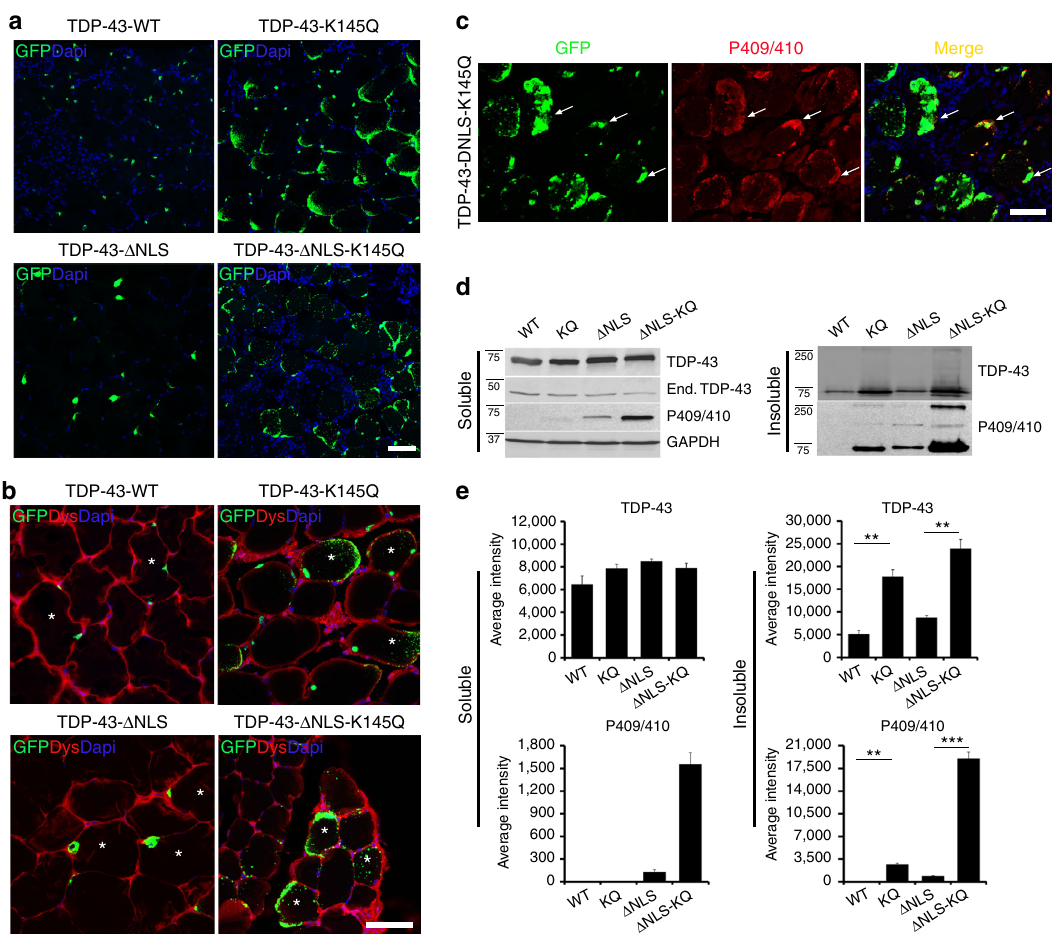
Fig. 2 TDP-43 acetylation-mimics generate hallmark disease pathology in vivo in mouse skeletal muscle. a Immuno fl uorescence analysis was performed on mouse tibialis anterior (TA) muscles electroporated with the indicated GFP-tagged TDP-43 plasmids for 4 days. b TA muscle sections were double-labeled with GFP ( green ) and dystrophin (Dys, red ) antibodies to mark the muscle periphery, while nuclei were stained with DAPI ( blue ). c TA muscles expressing TDP-43- Δ NLS-K145Q were double-labeled with GFP and phospho-TDP-43 (P409/410) antibodies to mark pathological TDP-43 aggregates. White arrows highlight phosphorylated TDP-43 accumulation. d Electroporated TA muscles were harvested, fractionated into soluble and insoluble fractions, and analyzed by immunoblotting using TDP-43, P409/410, and GAPDH antibodies. Shown is a representative immunoblot from N = 3 independent experiments. e Quanti fi cation of d illustrates increased insoluble TDP-43 in muscles expressing TDP-43- Δ NLS-K145Q. Error bars indicate SEM, and the asterisk indicates statistical signi fi cance with *** p -value < 0.001 and ** p -value < 0.01, as measured by Student ’ s t -test. Scale bar = 50 μ